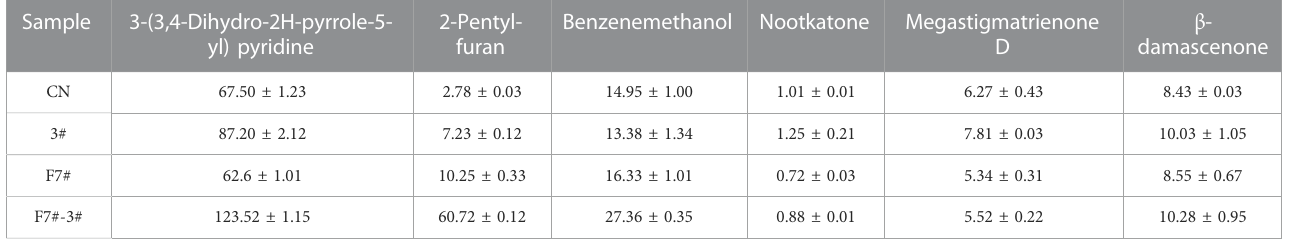
TABLE 9 Main differential fl avor compounds content of combination of strains F7# and 3# (ug/g). Sample